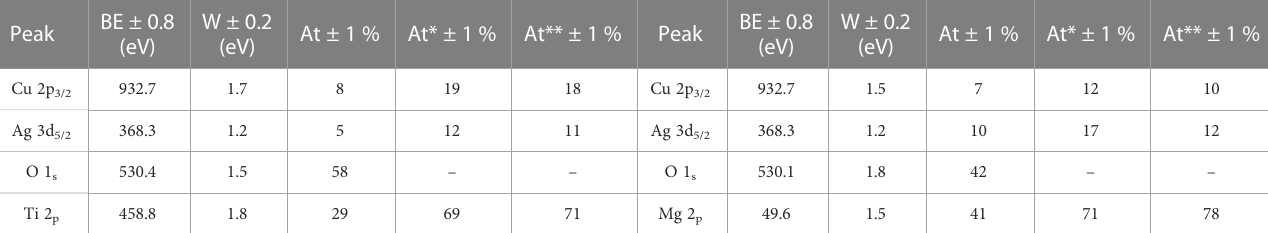
TABLE 1 The binding energy (BE) positions, full width at half maximum (FWHM), and atomic concentrations of Ti-Ag-Cu obtained from the fi tting procedure. BE ± 0.8 Peak (eV)